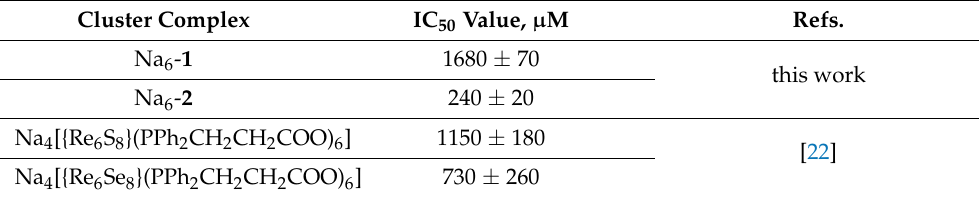
Figure 6. Viability of Hep-2 cells treated with Na 6 - 1 ( a ) and for Na 6 - 2 ( b ), determined by double-staining with Hoechst 33342/PI. Table 2. The IC 5 0 values of [{M 6 Q 8 }(PPh 2 CH 2 CH 2 COO) 6 ] n (M = W, Re) clusters.